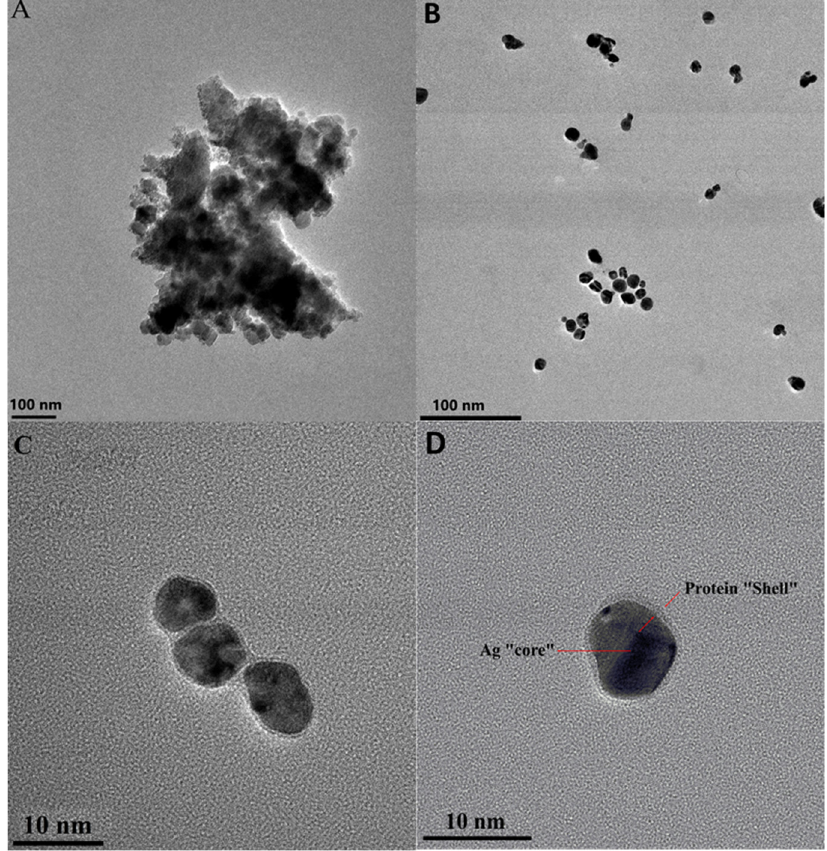
Figure 2. ( A ) TEM micrograph of 2 × 10 − 10 M of methionine-covered AgNPs in the 10 mM phosphate buffer; ( B ) TEM micrograph of observed peptization process after addition of 5 × 10 − 6 M BSA; ( C ) TEM micrograph in the 10 nm resolution; ( D ) silver nanoparticle core and protein shell indicated by arrows.